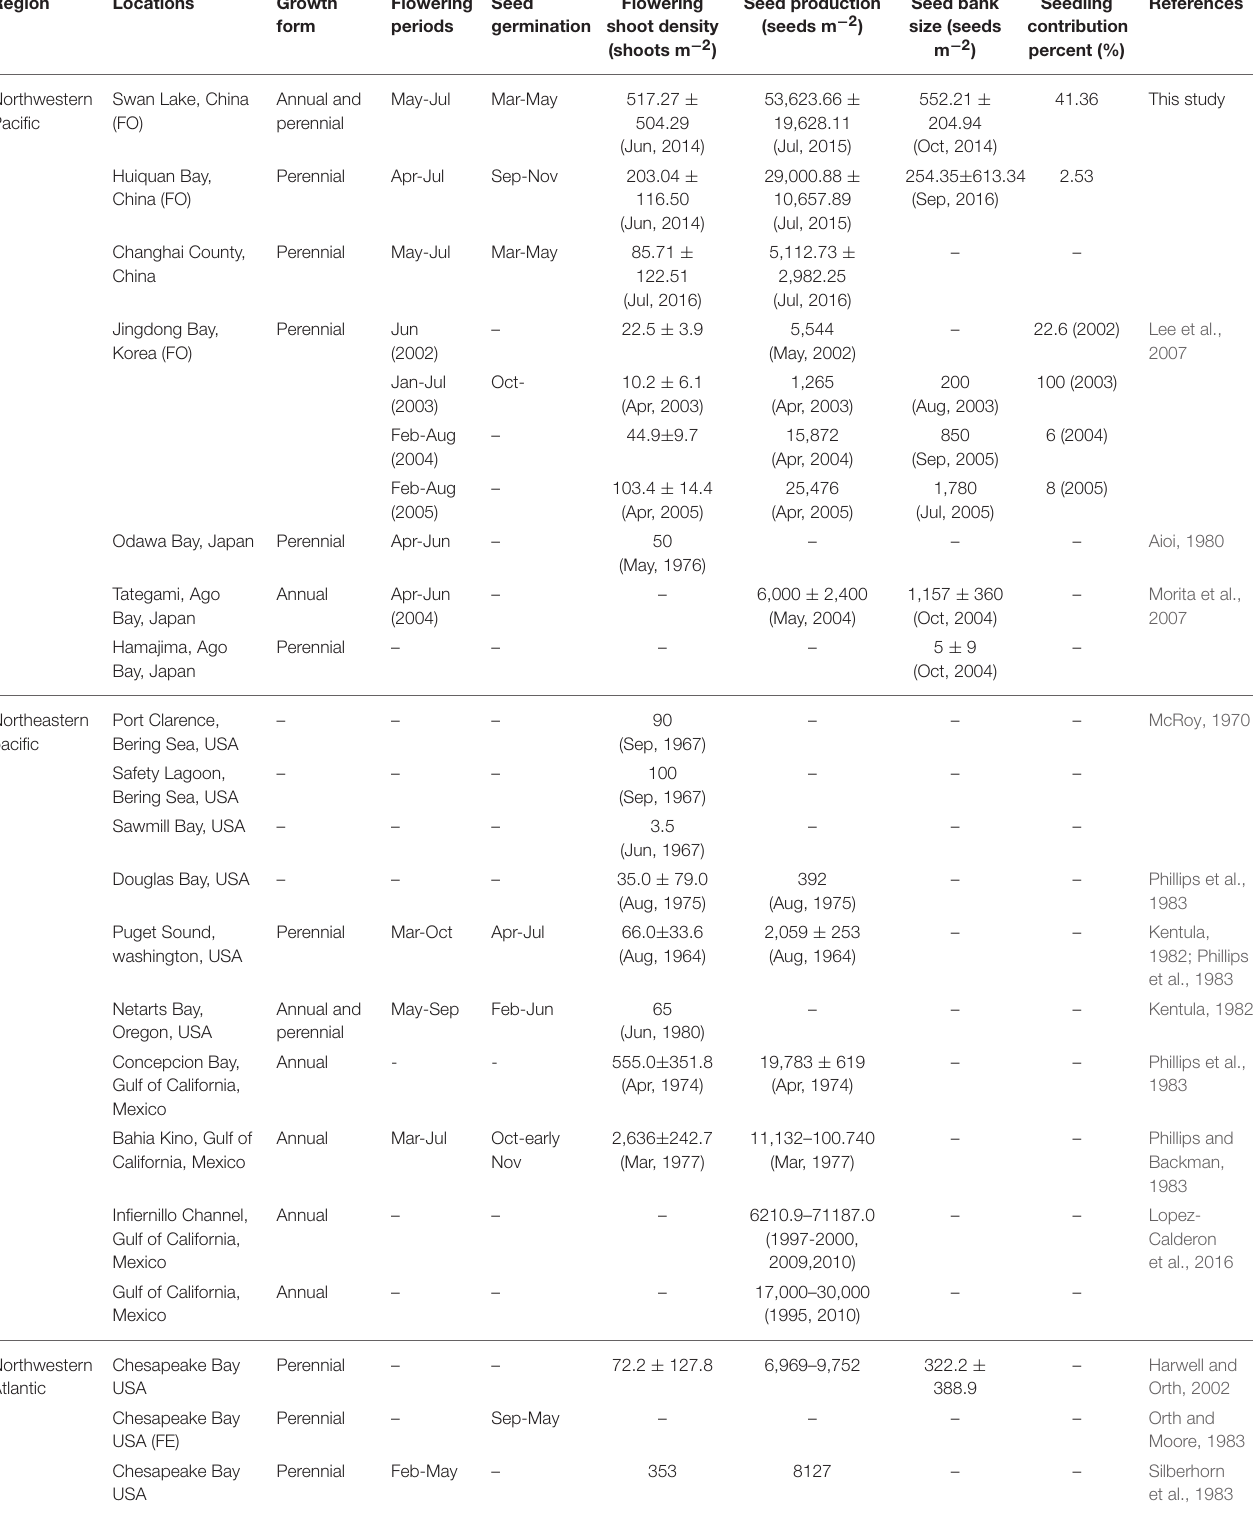
TABLE 5 | Comparison of sexual reproduction among Zostera marina populations from Swan Lake, Huiquan Bay, and other study sites. Region